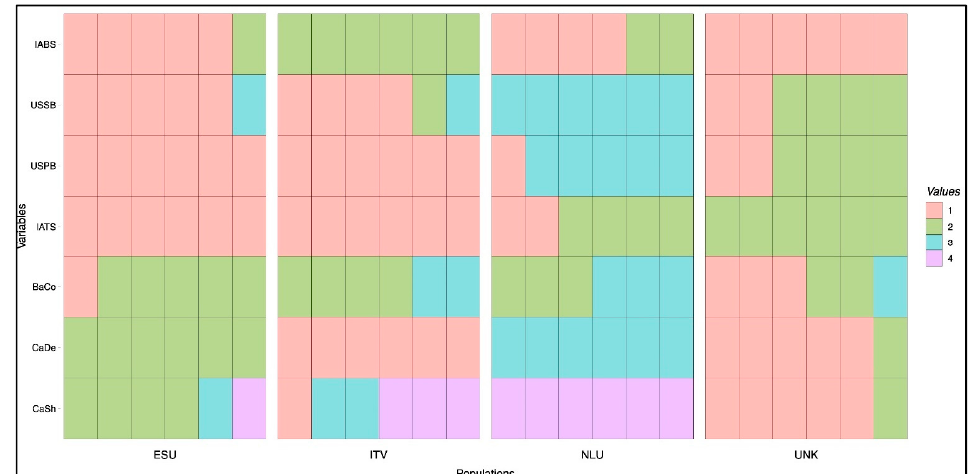
Figure 1. Distribution of qualitative morphological parameters of A. araucana within the four studied putative populations (ESU, UNK, NLU, ITV). CaSh = canopy shape (1—columnar, 2—elliptic, 3—globose, 4—pyramidal,). CaDe = canopy density (1—sparse, 2—medium, 3—dense). BaCo = bark colour (1—light grey, 2—greyish-green, 3—greyish brown). IATS = insertion angle of trunk scales (1—uniform, 2—variable). IABS = insertion angle of primary branch scales (1—angle ≤ 45°, 2—angle > 45°). USPB = uniformity of scale size on primary branch (high, medium, low). USSB = uniformity of scale size on secondary branch (high, medium, low).